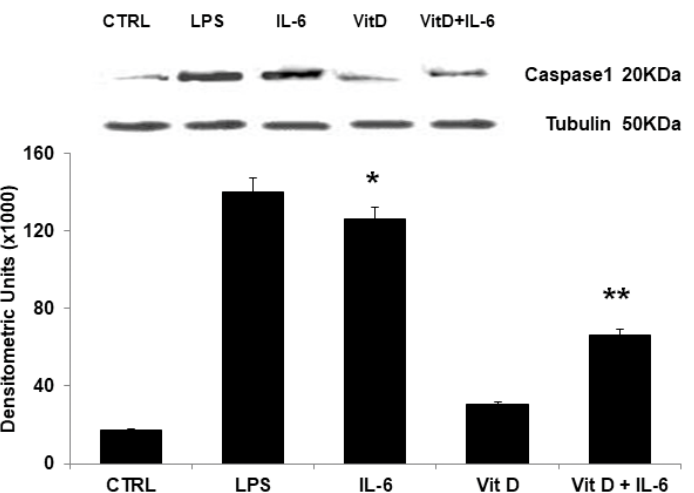
Figure 6. IL-6 caused a significant increase in Caspase-1 protein levels. These effects were prevented by treatment with VitD. Tubulin served as loading control. LPS served as positive control. Each bar represents the mean ± SD of 6 different experiments (* p < 0.001 vs. Control; ** p < 0.001 vs. IL-6; one-way ANOVA with Tukey’s post hoc test). The insert shows results of a representative experiment.